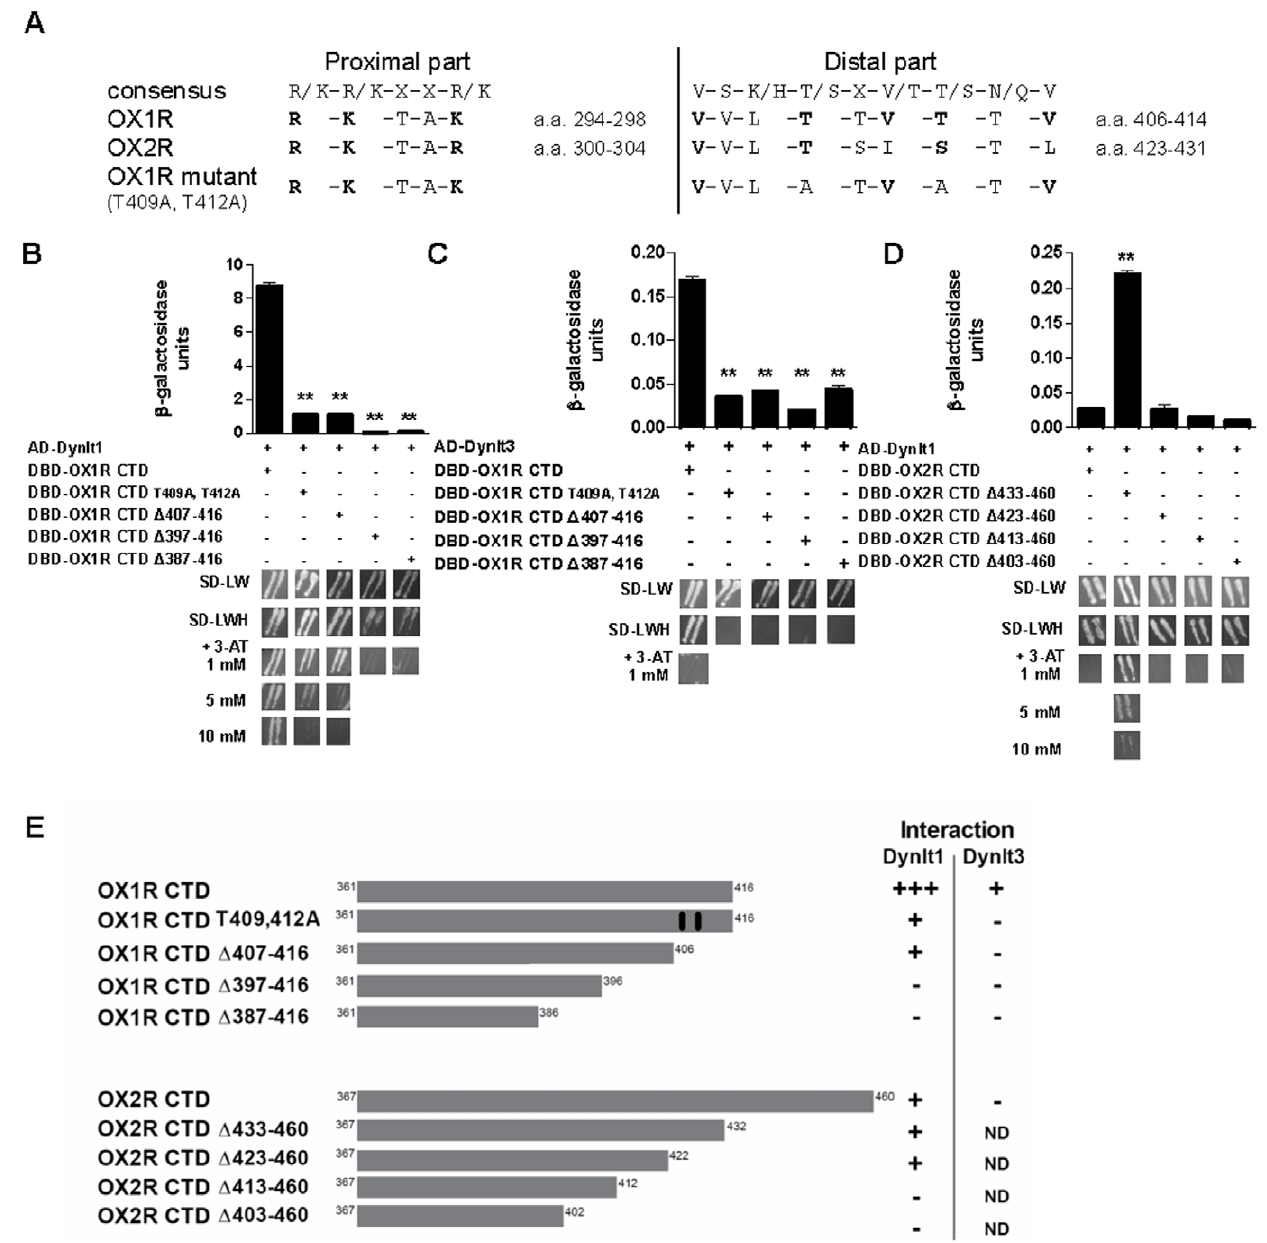
Figure 4. Regions of orexin receptors involved in their interaction with Dynlt1 and Dynlt3. ( A ) Identification of a putative bipartite Dynlt1-binding motif in orexin receptors. The proximal portion of the structure shown here, located in the third intracellular loop of orexin receptors, is not included in the soluble orexin receptors CTD containing the distal part and used for yeast two-hybrid assays (Fig. 1 and 3). Amino acid numbering refers to mouse sequences. Amino acids of the consensus delineated from other Dynlt1-binding proteins are shown in bold, [30,31]. In the OX1R CTD mutant, two conserved Thr were mutated to Ala (409 and 412, numbering from full-length OX1R). ( B, C, D ) b -galactosidase (top panels) and HIS3 (bottom panels) assays were performed on yeast transformed with plasmids expressing different combinations of orexin receptor and Dynlt1/Dynlt3. Interactions of OX1R CTD with Dynlt1 and Dynlt3 are reduced when Thr 409 and 412 of OX1R CTD are mutated into Ala. Deleting the extra amino acids of OX2R CTD favors its interaction with Dynlt1, while deleting the next 10 amino acids (comprising the distal part of the Dynlt1- binding motif) abolishes this effect. ( E ) Summary of OX1R CTD and OX2R CTD constructs tested and their relative interaction strength with Dynlt1 and Dynlt3. OX1R CTD T409, 412A, OX1R CTD with T409 and T412 mutated into alanine residues; OX1R CTD D 407–416, OX1R CTD lacking the last 10 a.a.; OX1R CTD D 397–416, OX1R CTD lacking the last 20 a.a.; OX1R CTD D 387–416, OX1R CTD lacking the last 30 a.a.; OX2R CTD D 433–460, OX2R CTD lacking the extra 28 a.a. compared to OX1R CTD; OX2R CTD D 423–460, OX2R CTD lacking the last 38 a.a.; OX2R CTD D 413–460, OX2R CTD lacking the last 48 a.a.; OX2R CTD D 403–460, OX2R CTD lacking the last 58 a.a. ND, not determined. Experiments were performed 3 times and the average is presented. **: p , 0.01 vs transformation with wild-type OX1R CTD or OX2R CTD.